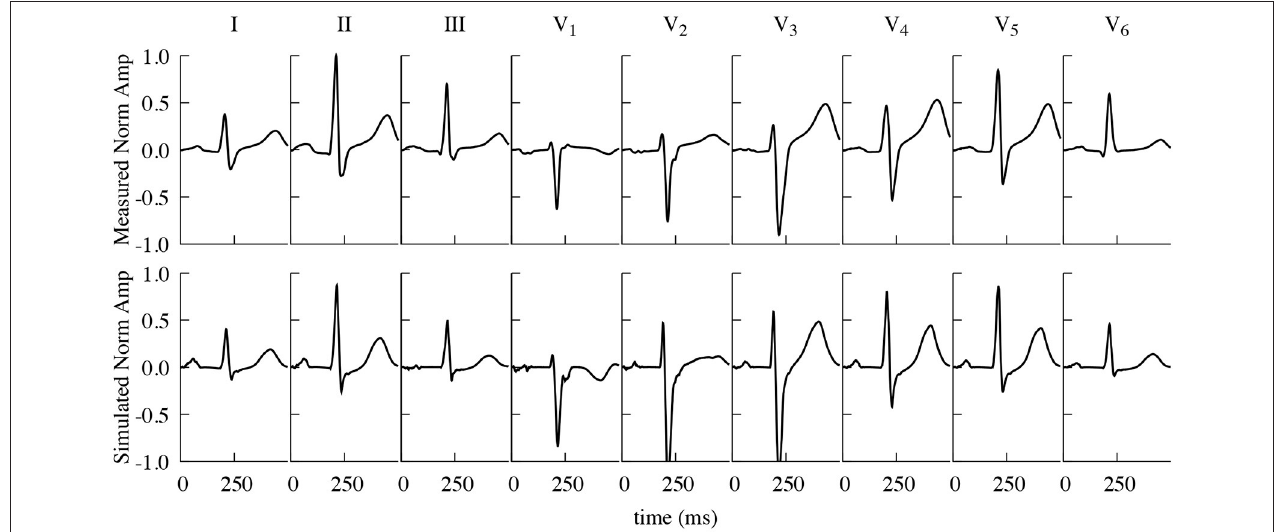
FIGURE 4 | Comparison of measured and simulated ECG traces. Measured (top) and simulated (including contraction) (bottom) Einthoven and Wilson traces, normalized to the R-Peak of Einthoven II. Measured and simulated ECG traces show a strong correlation (Pearson’s r ), averaging 0.872 over all here displayed individual